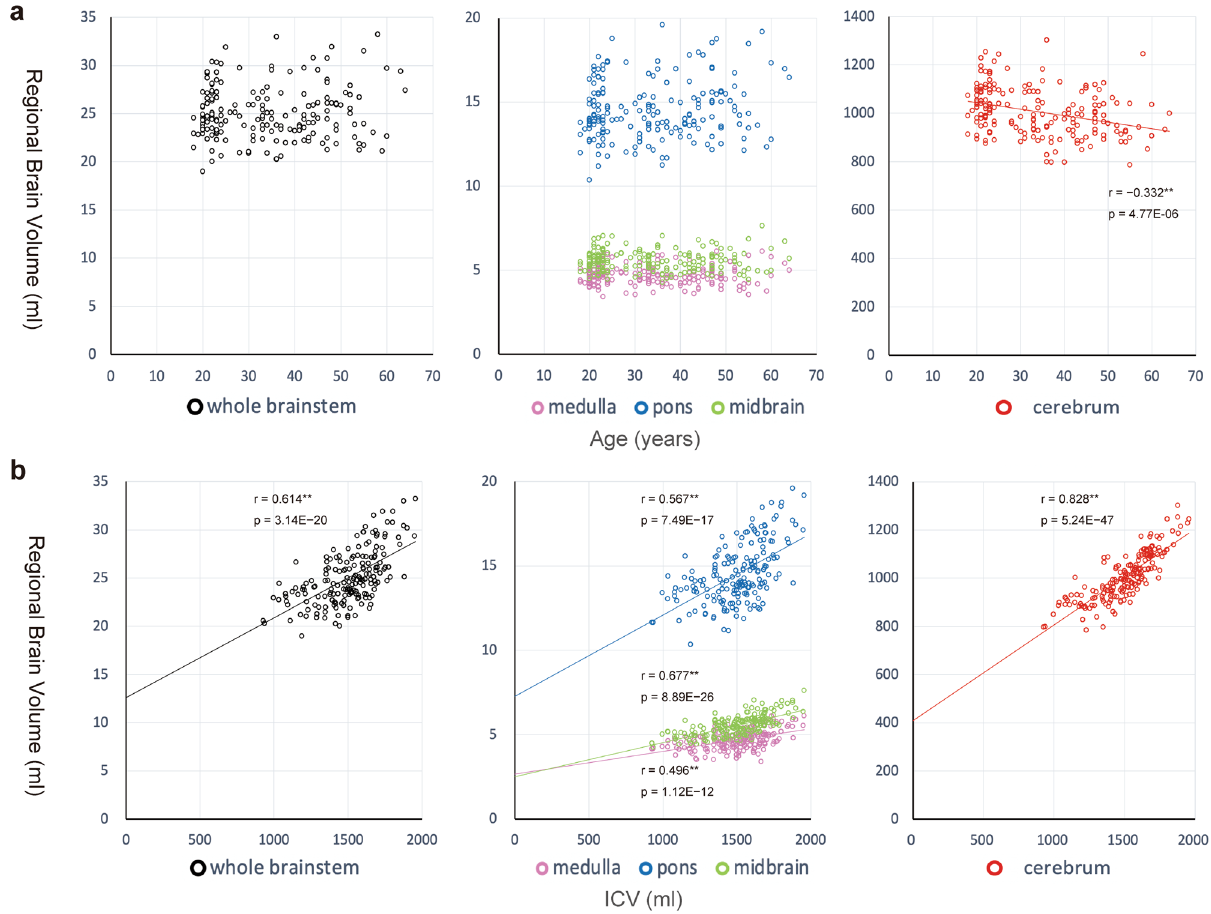
Figure 1. Relationship between each ROI volume and age (a) or ICV (b) in 182 healthy subjects. (a ) There were no significant correlations between regional volume and age for the whole brainstem (Pearson’s r = 0.093, P = 0.213), medulla (r = 0.029, P = 0.698), pons (r = 0.145, P = 0.050), or midbrain (r = 0.00046, P = 0.995), whereas a significant negative correlation was found for the cerebrum (r = − 0.332, P = 4.77E-06). (b ) There were significant positive correlations between regional volume and ICV (r = 0.496, 0.567, 0.677, 0.614, and 0.828 for the medulla, pons, midbrain, whole brainstem, and cerebrum, respectively; P < 1.0E-11). However, none of the ROI volumes showed direct proportionality to ICV, reflected by the positive y-intercepts of the regression lines on the scatterplot with ICV on the x-axis and each regional volume on the y-axis. *Significant at P < 0.05. ROI Region of interest, ICV Intracranial volume.